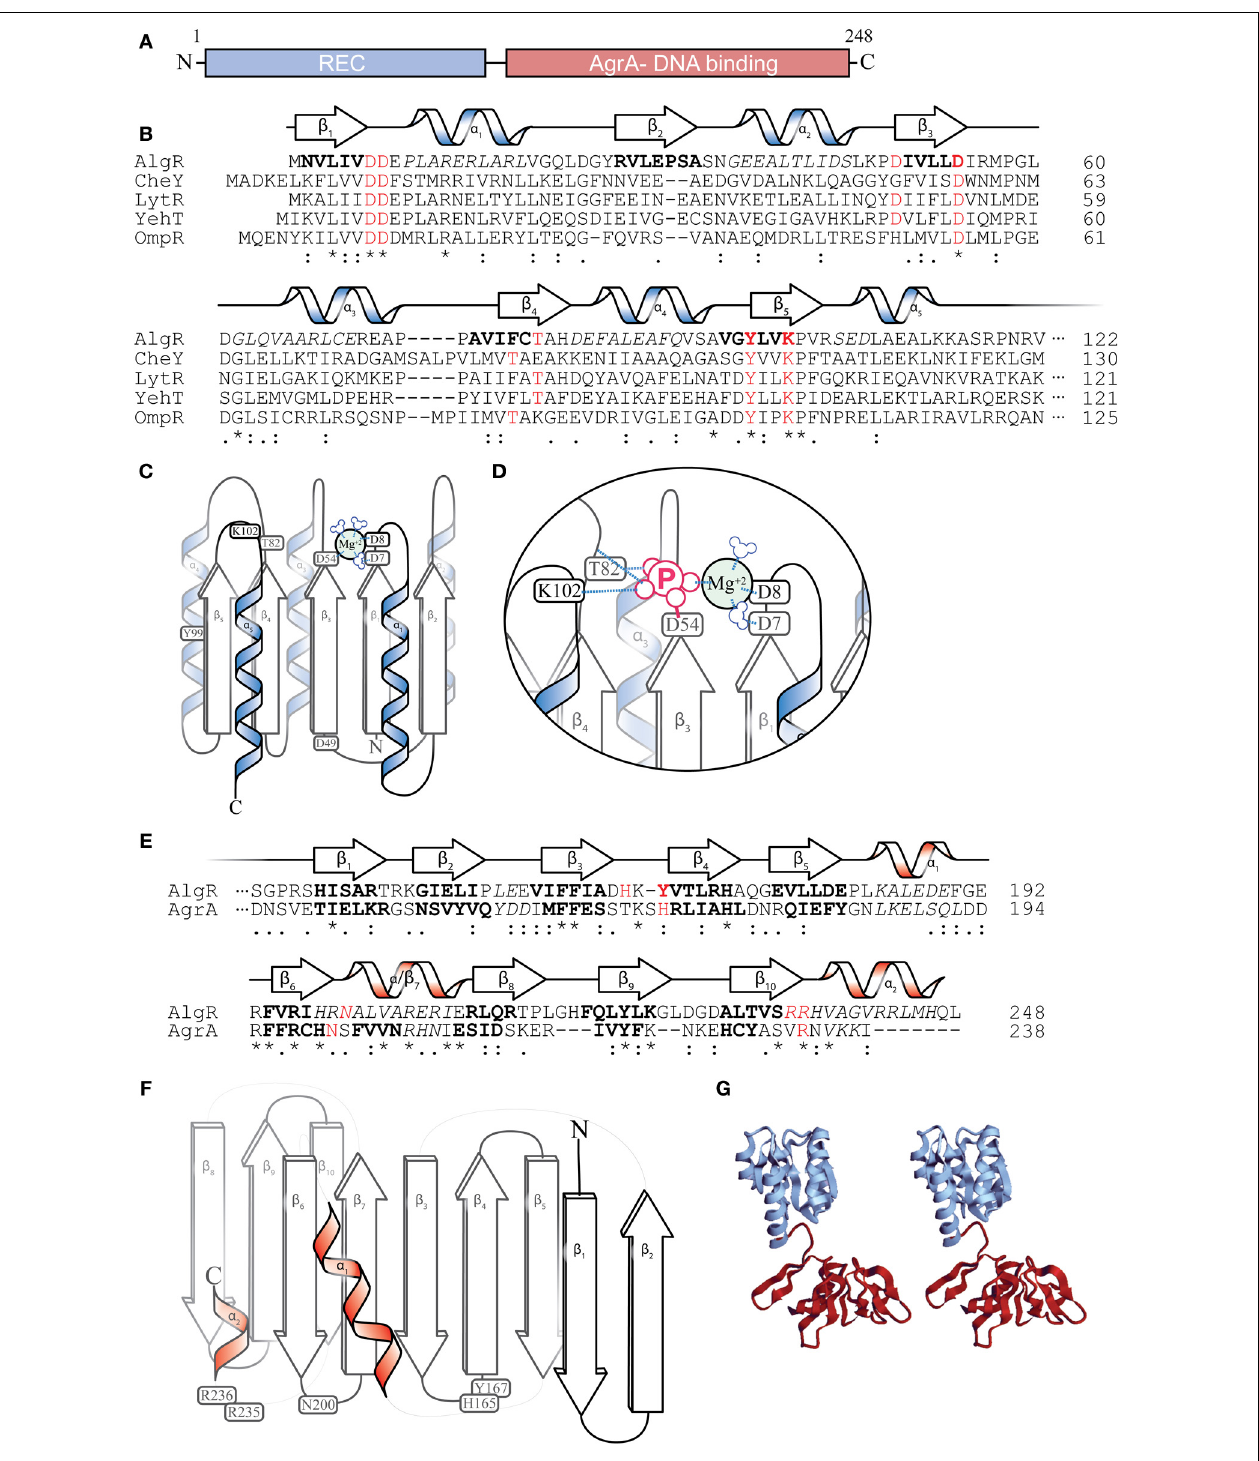
FIGURE 4 | AlgR Structural predictions. (A) Diagram depicting two major domains of the 249 amino acid AlgR polypeptide. (B) A ClustalW sequence alignment of the amino acid sequence of the N-terminus CheY-like receiver (REC) domain of AlgR and its orthologs. “ ∗ ” = identical amino acids, “:” = conserved substitutions, “.” = semi-conserved substitutions. Red color denotes select highly conserved amino acids, most with functional importance for phosphorylation, italics indicate alpha helices, bold indicates